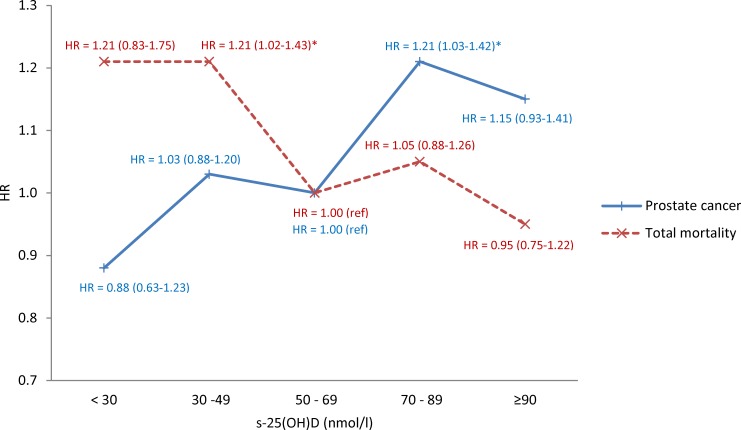
Hazard Ratios (HR) with 95% confidence intervals for total mortality (red line) and incident prostate cancer (blue line) by category of s-25(OH)D.Separate analyses were performed for the two endpoints. 25(OH)D 50–69 nmol/l is the reference category. In the total mortality analysis, adjustment was made for age, case status, month of blood sampling, examination, physical activity, BMI, smoking and education. In the prostate cancer incidence analysis adjustment was made for age, month of blood sampling, examination and education.